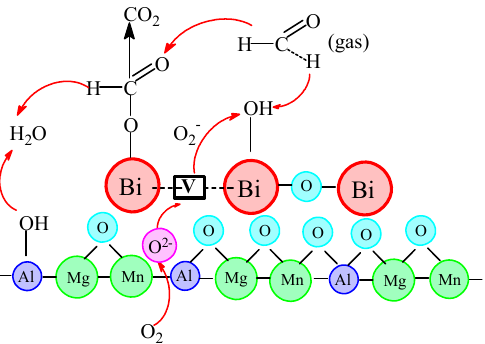
Figure 11. FTIR spectra of ( A ) 0.01BiOCl/MnMgAl − HT and ( B ) 0.01BiOCl/MnMgAlO